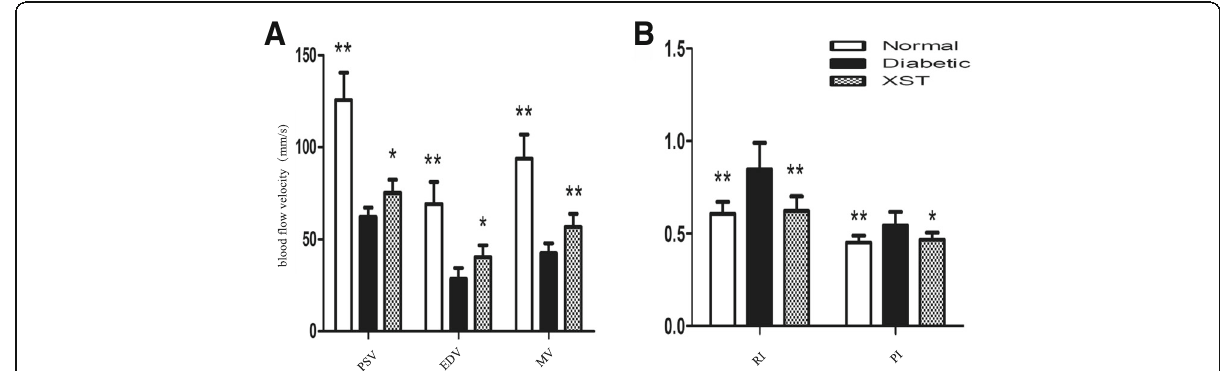
Fig. 2 The effect of XST on blood flow in CRA of rats. At the end of the treatment, rats were anesthetized and blood flow in CRA was measured by color doppler imaging. XST had a remarkable increase in PSV, EDV and MV and lower levels of PI and RI. Data were represented as mean ± S.D. ( n = 6 – 10). *: P < 0.05, **: P < 0.01, compared to Diabetic. CRA, central retinal artery; PSV, peak systolic velocity; EDV, end-diastolic velocity; MV, mean velocity; RI, resistance index; PI, pulsatility index. ( a ) PSV, EDV and MV of CRA. ( b ) RI and PI of